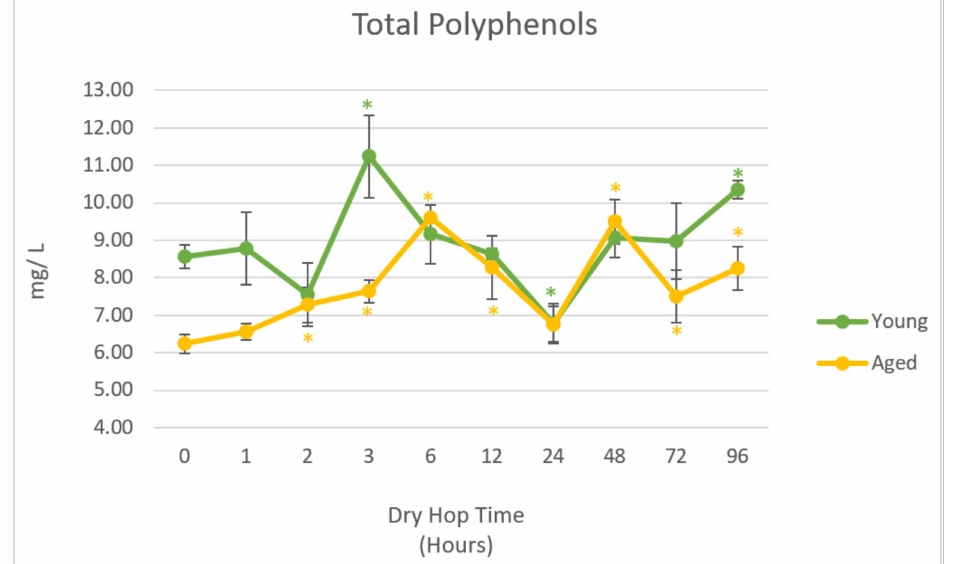
Figure 2. Summation of polyphenol concentrations (mg/L) measured in Young and Aged beer ( n = 3). Statistical significance compared to control beers ( t = 0) only within the same aging treatment. *: α =